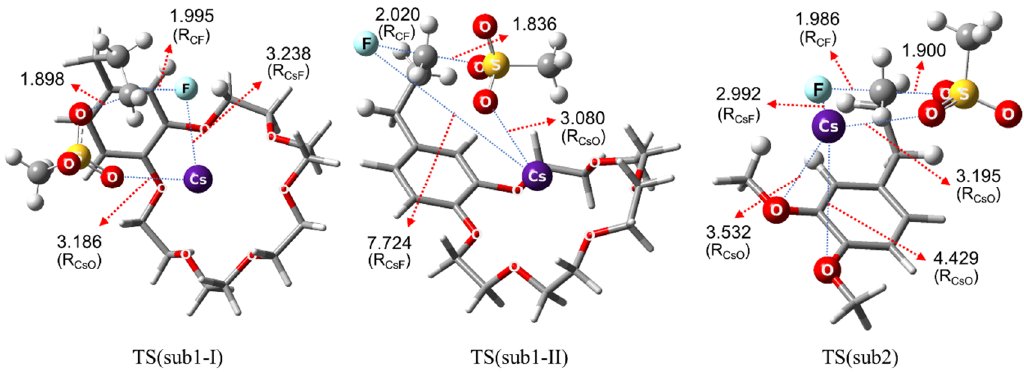
Figure 3. Transition states in S N 2 fluorination of 1 and 2 using CsF. Bond lengths in Å.